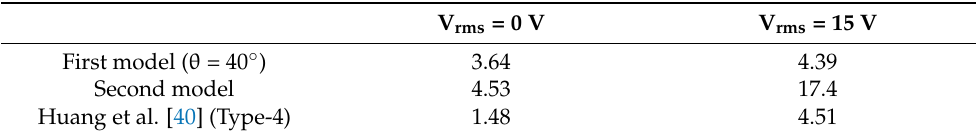
Figure 4. Transient evolution of the average surface concentration of CRP complex for the two types of biosensors for: ( a ) V rms = 0 V and ( b ) V rms = 15 V. In the case of V rms = 0 V (Figure 4a), the binding reaction rate related to the circular reacting surface without electrothermal force is smaller than that related to the reaction surface having the form of a circular ring. Table 2. Comparison of initial slope ( × 10 − 11 ) for our proposed models with the results of Huang et al.